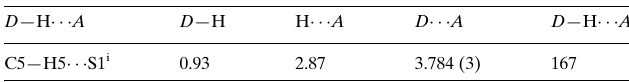
Hydrogen-bond geometry (A˚ , (cid:2)